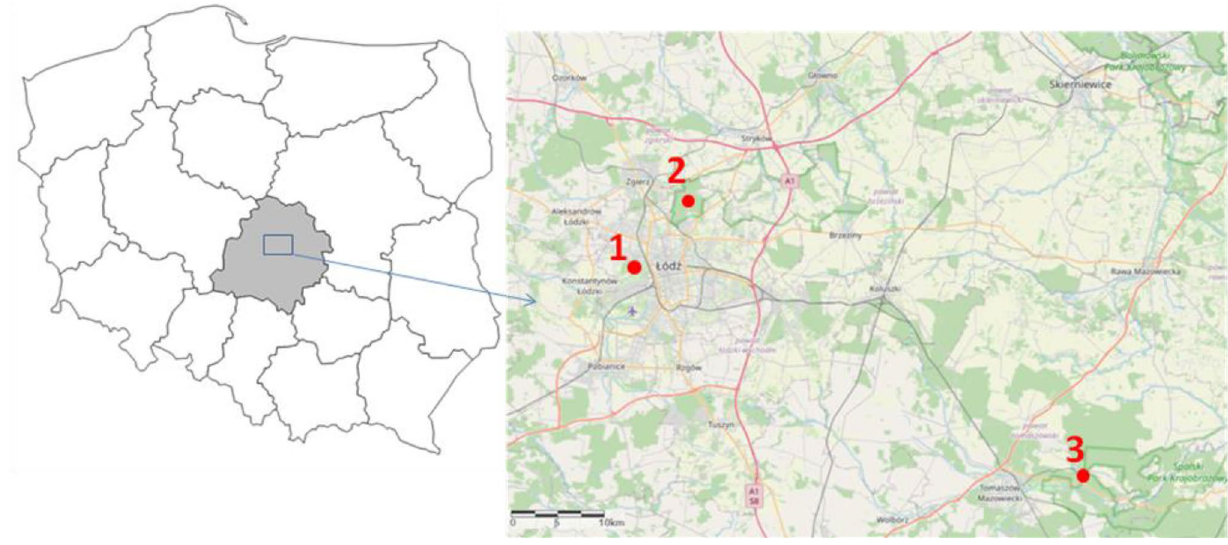
Figure 2. Map of the study area showing the spatial location of the study sites (1—urban parkland; 2— suburban (Łagiewniki) Forest; 3—urban (Spała) Forest). The map of Poland was generated by applying Map function ver. 3.1.85 implemented in STATISTICA software 71 The map with marked study sites was created using QGIS 3.16.3 Hannover software (https:// www. qgis. org/). Both maps were merged and edited in GIMP v. 2.10.10 (GIMP Development Team 2019: http:// gimp.